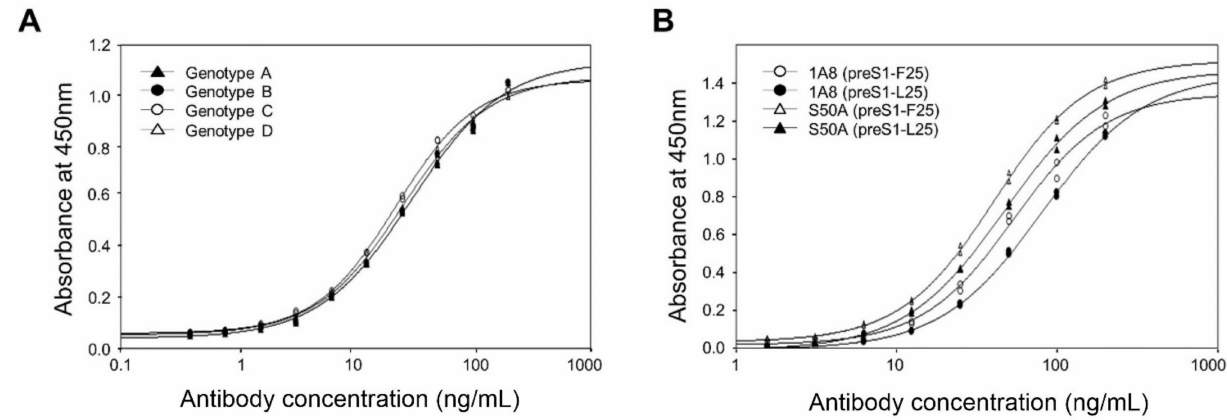
Figure 6. ( A ) Analysis of the antigen-binding activities of 1A8 to purified GST–preS1 (aa 1–56)–strep of genotypes A–D. The preS1 antigen (50 nM/well) was coated and incubated with a serially diluted antibody to perform indirect ELISA. ( B ) Analysis of the antigen-binding activities of 1A8 and the S50A mutant to purified GST–preS1 (aa 1–56)–strep of genotype A with Phe25 or Leu25. The preS1 antigen (100 ng/well) was coated and incubated with a serially diluted antibody to perform indirect ELISA. Values were obtained from duplicate wells and are expressed as the mean ±